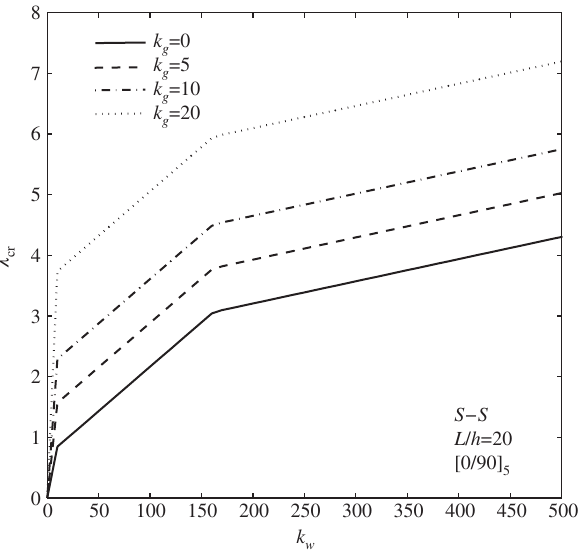
Figure 2 Influence of the shear constant of elastic foundation on λ